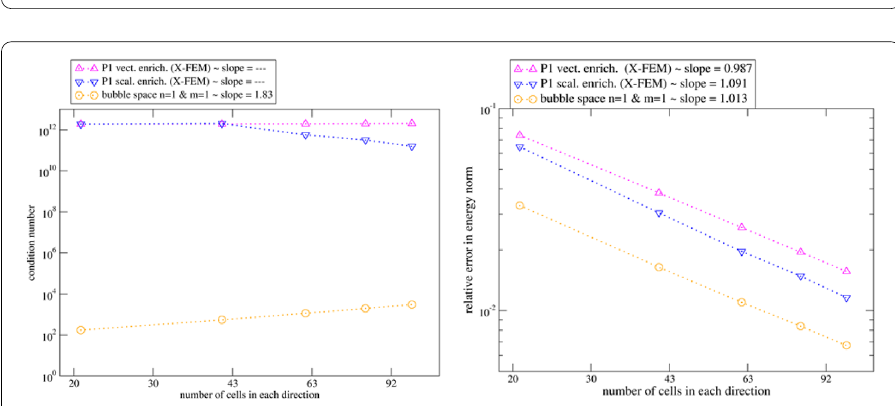
Fig. 35 Convergence and conditioning analysis with linear elements for inclined crack at an angle of 44 . 9